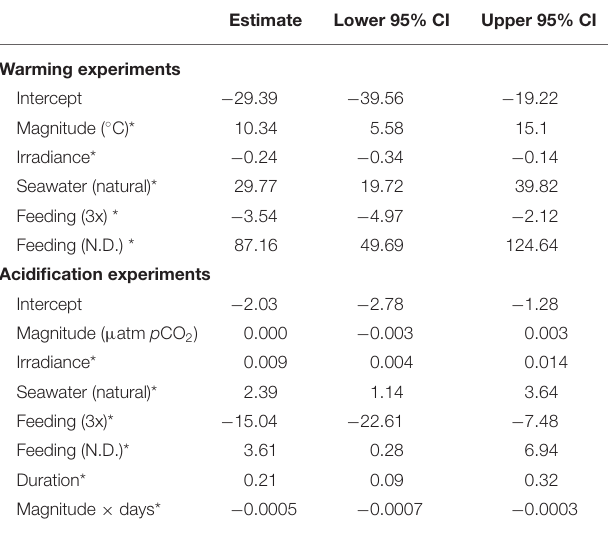
TABLE 1 | Effect size estimate and 95% confidence intervals of experimental design parameters calculated for all warming and acidification experiments.